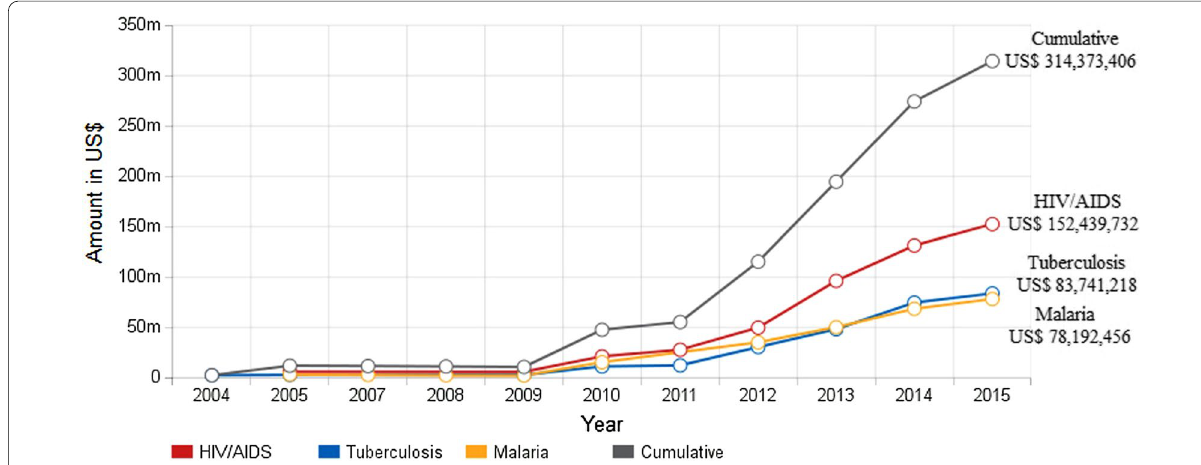
Fig. 2 The Global Fund’s disbursements to Myanmar. Source : The Global Fund. The Global Fund: Myanmar—Investments & results. Retrieved December 8, 2015, from http:// www. thegl obalf und. org/ en/ portf olio/ count ry/ resul ts/? loc